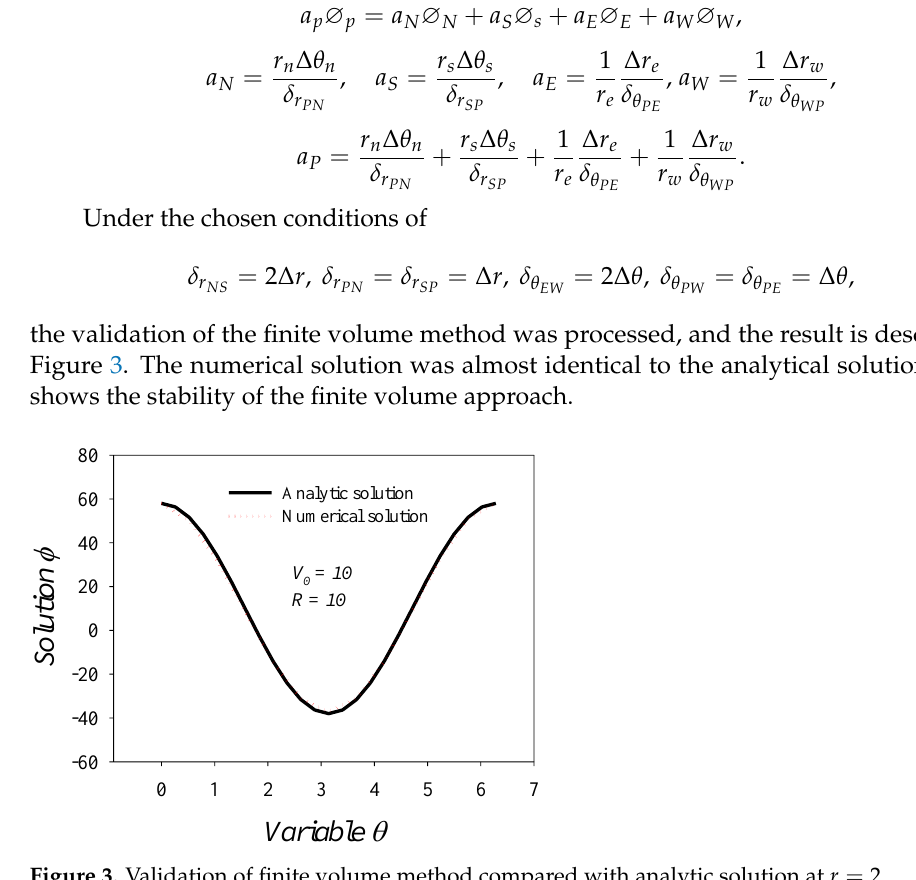
Figure 3. Validation of finite volume method compared with analytic solution at r = 2.